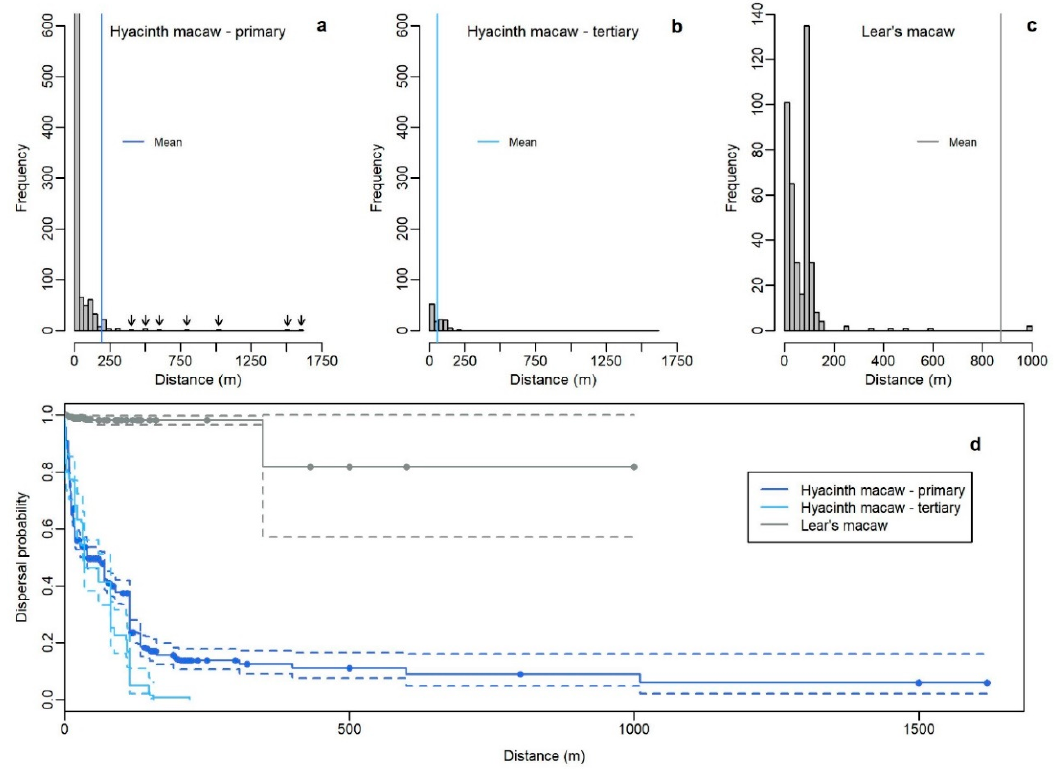
Figure 4. Distribution of fruit dispersal distances recorded for primary ( a ) and tertiary ( b ) dispersal in hyacinth and Lear’s macaws ( c ). Vertical lines show the estimated mean dispersal distances. ( d ) Kaplan–Meier estimates of dispersal functions; dashed lines show 95% confidence bounds, and solid circles indicate censored (minimum distance) observations. Table 3. Estimated mean (+SE) and median (95% CI) dispersal distances for all primary and tertiary dispersal events and each palm species, indicating the total number of recorded dispersal distances (Nt), the number of recorded exact distances (Ne), and the upper limit (i.e., the maximum distance observed) used for calculating the mean dispersal distance for each species (UL).